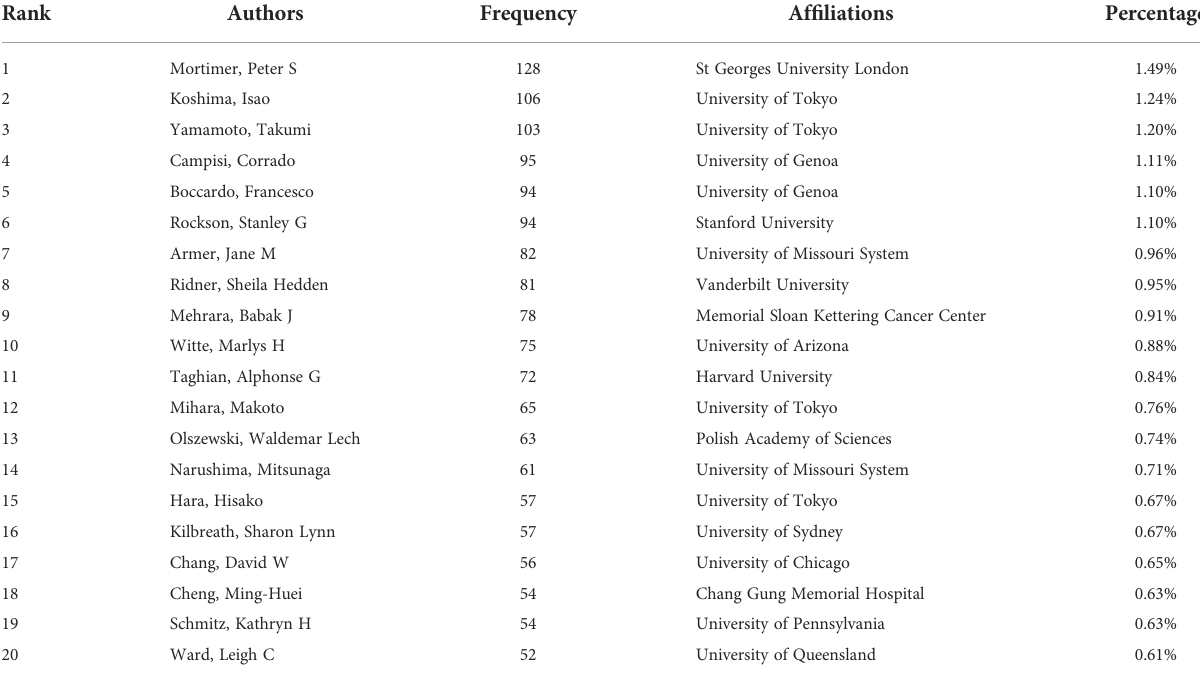
TABLE 3 The top 20 authors in terms of the number of publications.